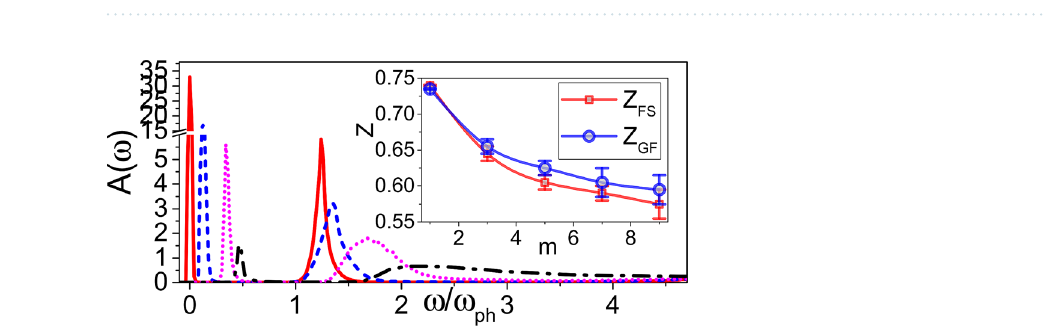
Figure 3. Contour plot of the spectral function intensity at δ the large/small intensity. Symbols connected with lines mark locations of the spectral density maxima, see also 4 (squares connected by the solid line), δ 3.8 10 Fig. 4, for: δ − = × 0.015 (diamonds connected by the dotted line). In the inset we present the effective coupling line), and δ ≈ constant (cid:31) e deduced from the scaling relation (2) using experimental data for LSCO 21 (squares connected by a dashed line) and locations of theoretical spectral density maxima in Fig. 4 (circles connected by a solid line). We also re-plot the same theoretical data by using 4 δ for the horizontal axis (diamonds connected by a dotted line). Spectral densities were computed for self-energies evaluated up to order m 0.006 ), and m 5 ( δ 0.015 ). These expansion orders are enough to have converged results for the ( δ = = = corresponding carrier density (see Supplementary Material, Table I). Prepared by OriginPro 2016, http:// Origi nLab. com.